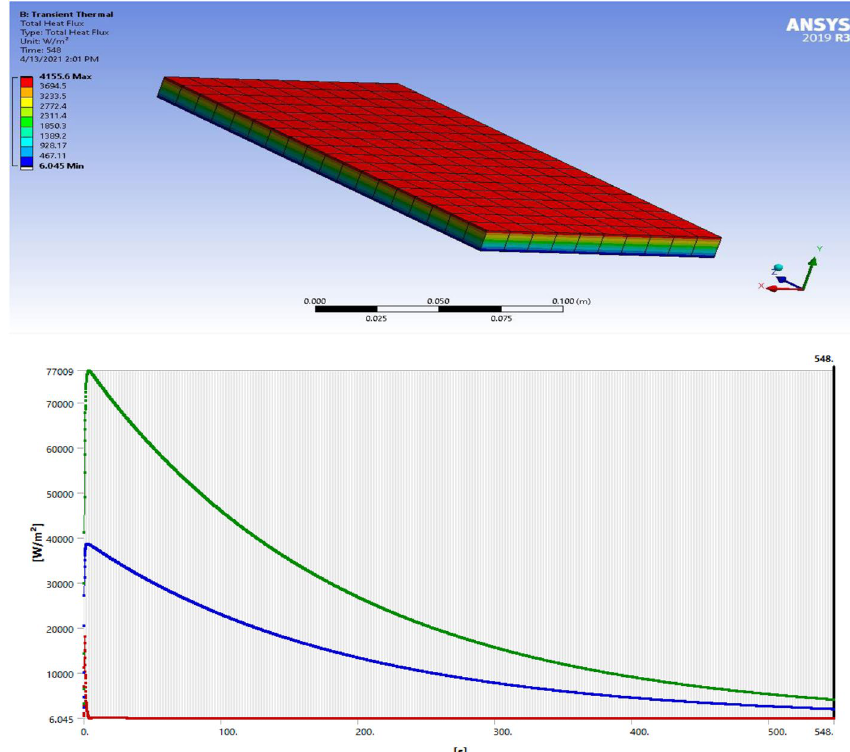
Fig. 17 CFD heat flux model and time plot at 110 °C, D